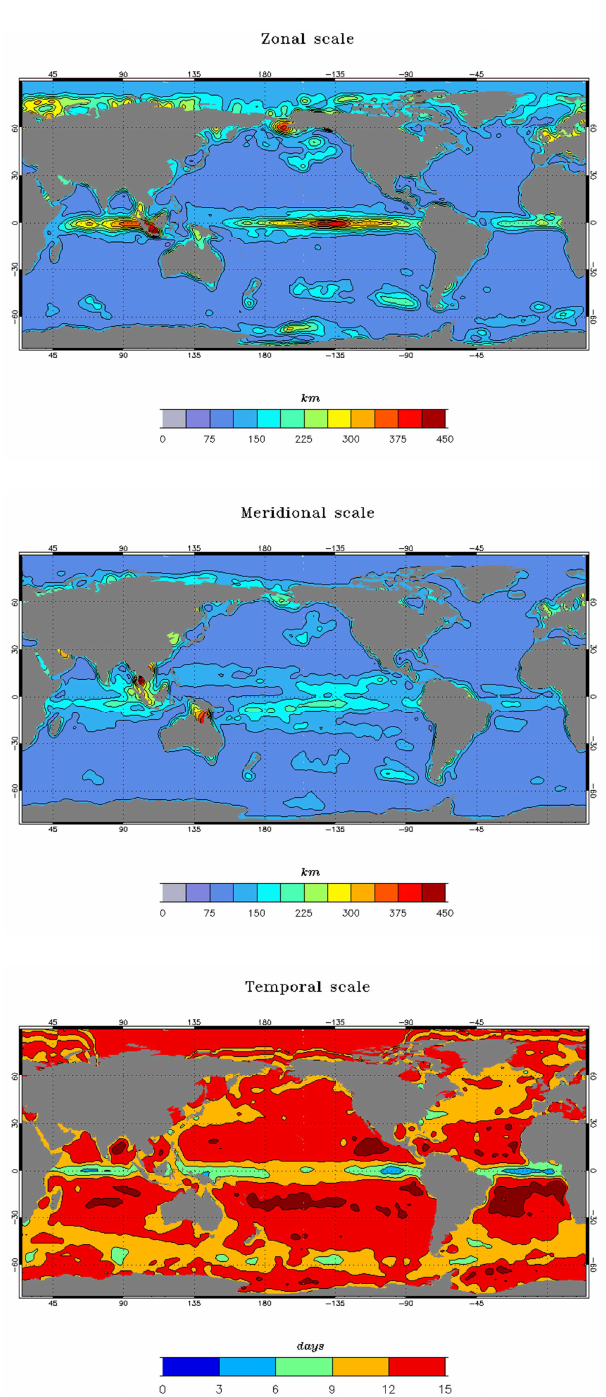
Fig. 3. Zonal, meridional (km) and temporal (days) correlation scales (from top to bottom) used by the IRG_DEV, HRZ_V1V2 and HRZ_DEV systems.